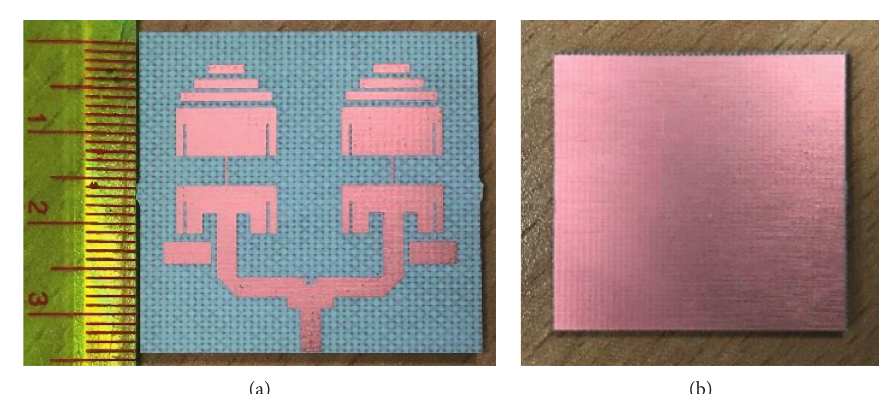
Figure 11: Fabricated prototype of proposed corporate-series-fed microstrip array antenna: (a) top view and (b) bottom